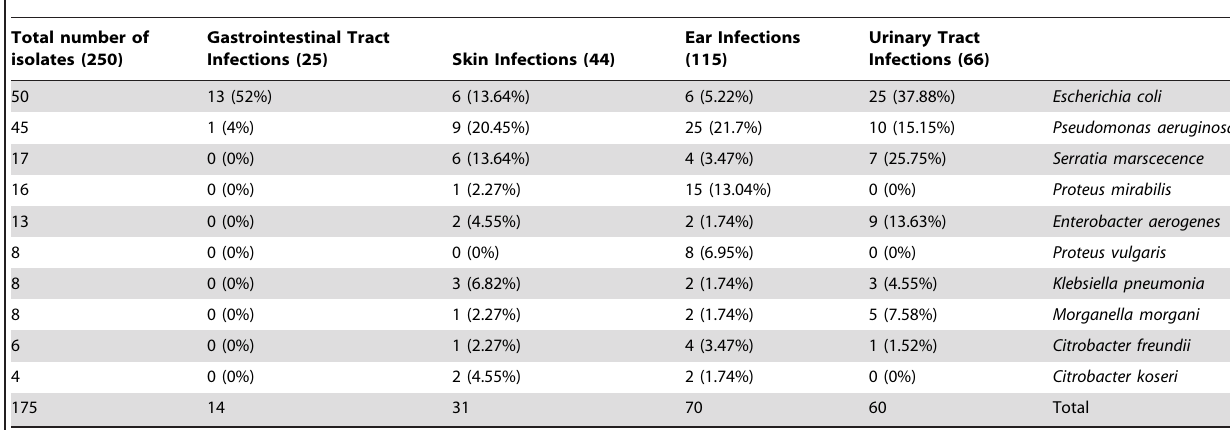
Table 1. Prevalence of the isolated microorganisms in different sample sites.